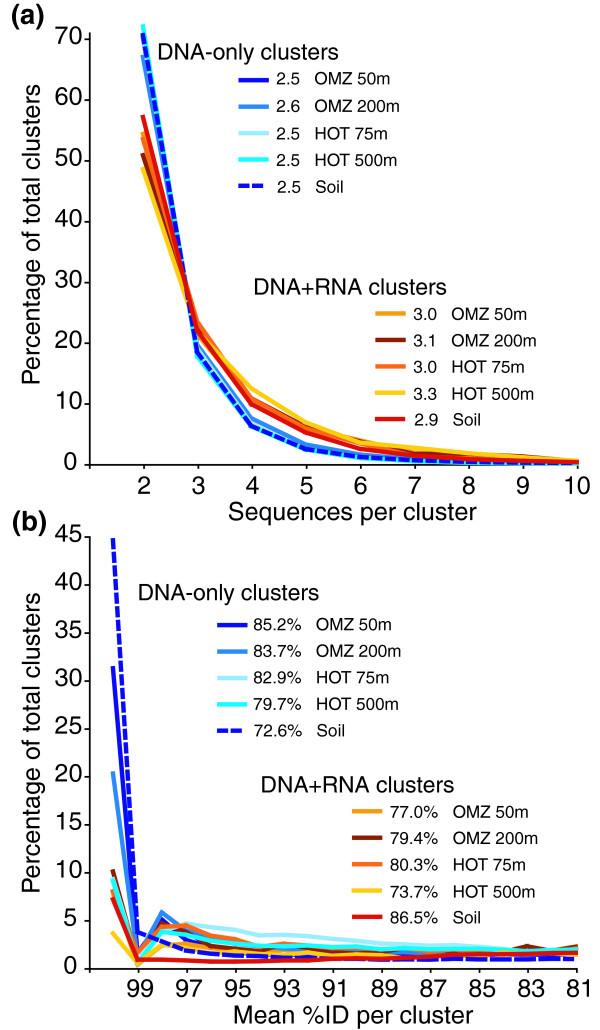
Database-independent cluster statistics. (a) Size and (b) percentage identity of clusters containing amino acid sequences present only in DNA datasets or in both DNA + RNA datasets from five representative samples. Cluster sizes are based on counts of only the DNA-derived sequences within each cluster type. Numbers in legends indicate mean cluster size (a) and mean amino acid identity (b). Amino acid sequences were clustered above a threshold identity of 55%.